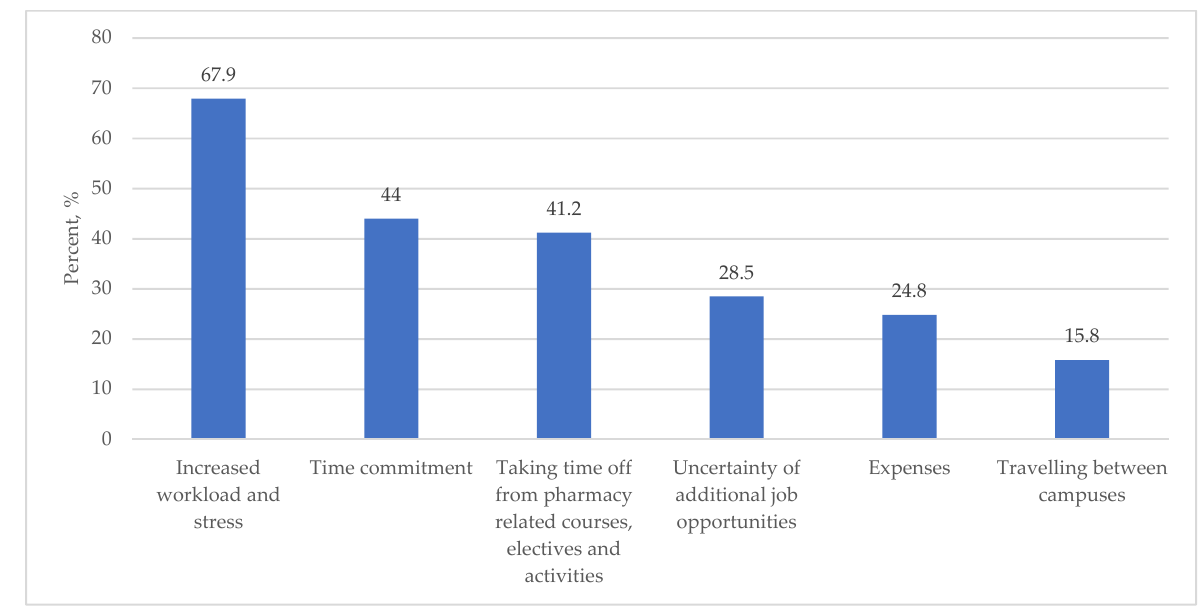
Figure 1. Perceived advantages in pursuing a PharmD/MPH Dual Degree .